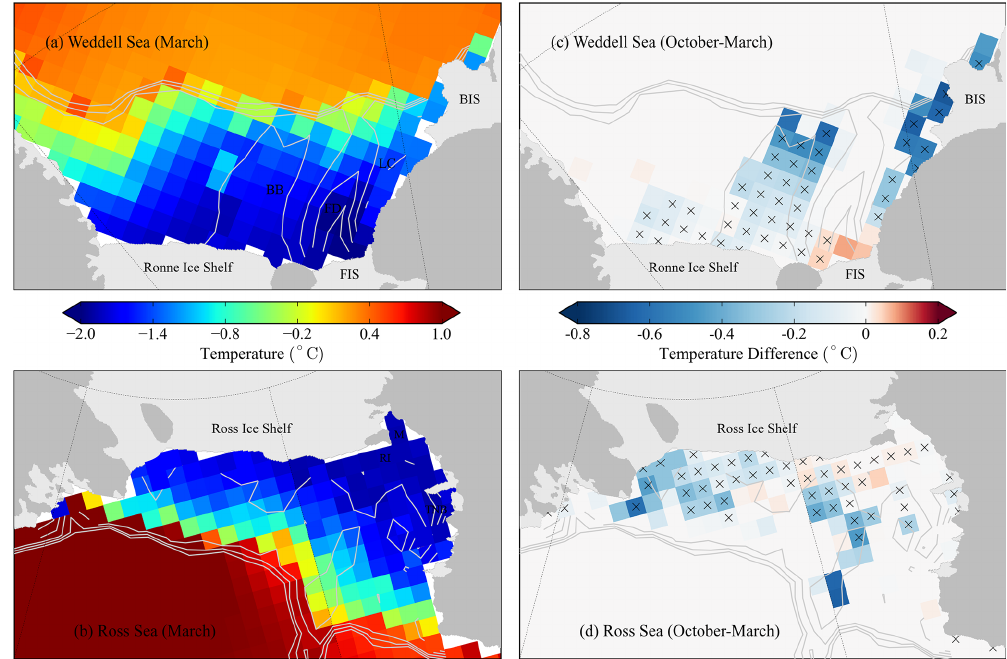
Fig. 10. As in Fig. 9 but for bottom